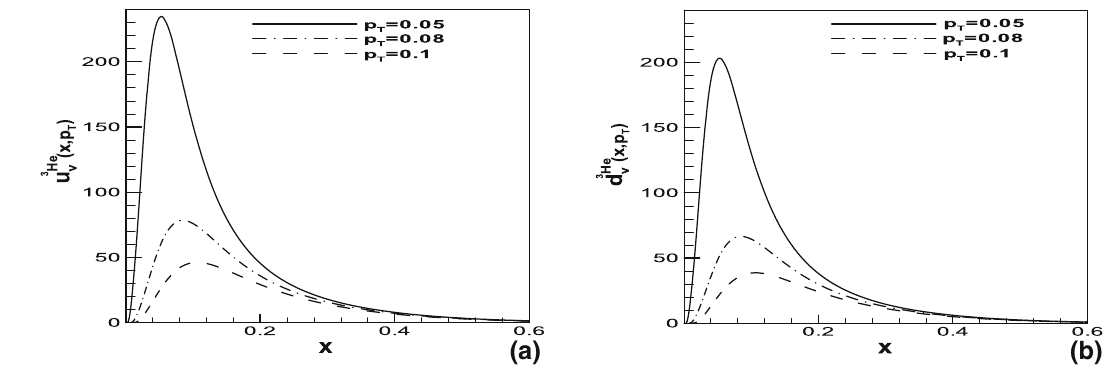
Fig. 1 The TMD valence quark distributions of 3 He nucleus: a u v ( x , p T ) , b d v ( x , p T ) with respect to x at p T = 0 . 05 GeV , 0 . 08 GeV and 0 . 1 GeV